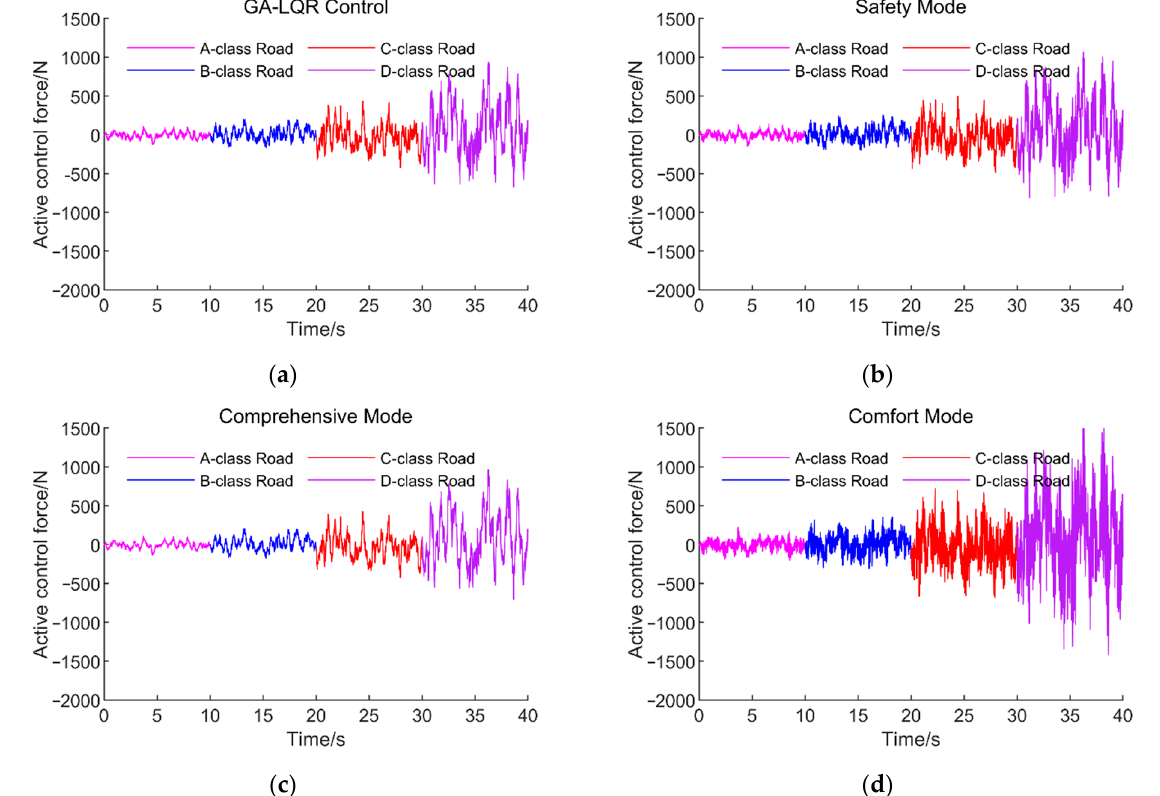
Figure 11. Time domain response curve of active control force. ( a ) GA-LQR control; ( b ) safety mode; ( c ) comprehensive mode; ( d ) comfort mode. Table 11. RMS values of active control force of each suspension type under different roads.